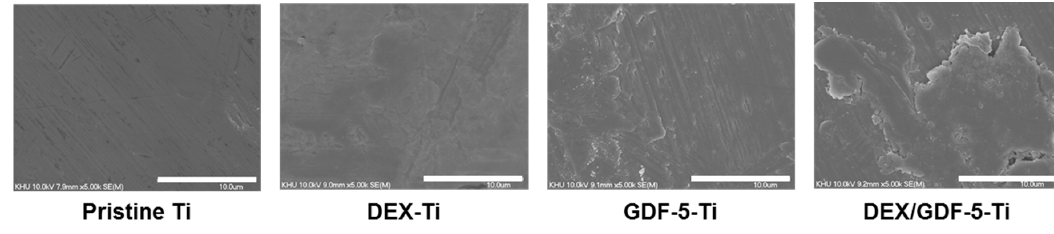
Figure 3. Scanning electron microscopy (SEM) images of pristine Ti, DEX–Ti, GDF-5–Ti and DEX/GDF-5–Ti disc samples observed at a magnification of 5 k. The white bar indicates 10 µ